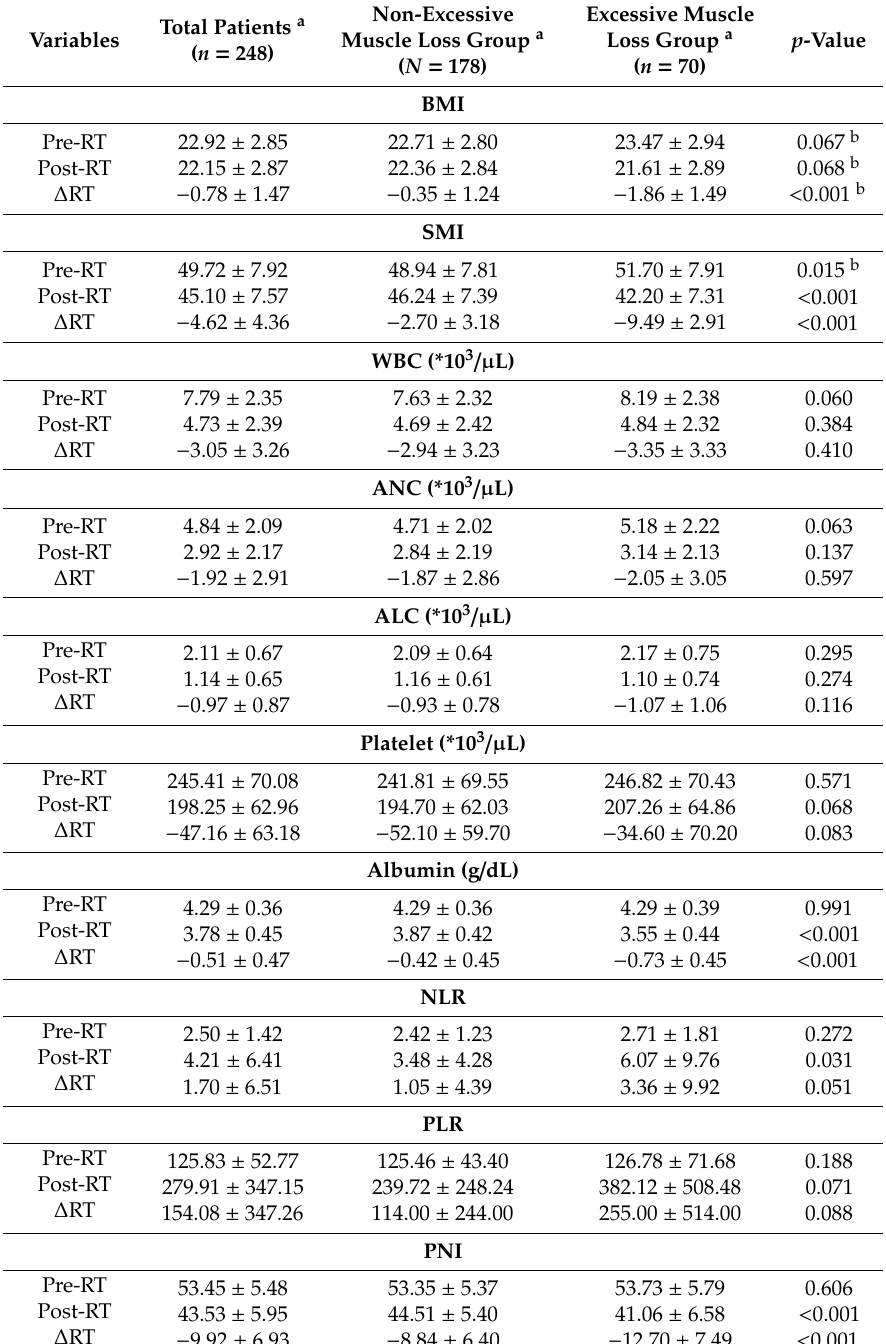
Table 4. Comparison of body components and laboratory test results between excessive muscle loss group and non-excessive muscle loss